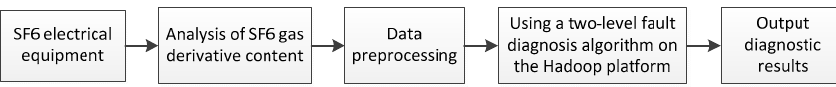
Figure 1. System block diagram for fault diagnosis of SF6 electrical equipment.